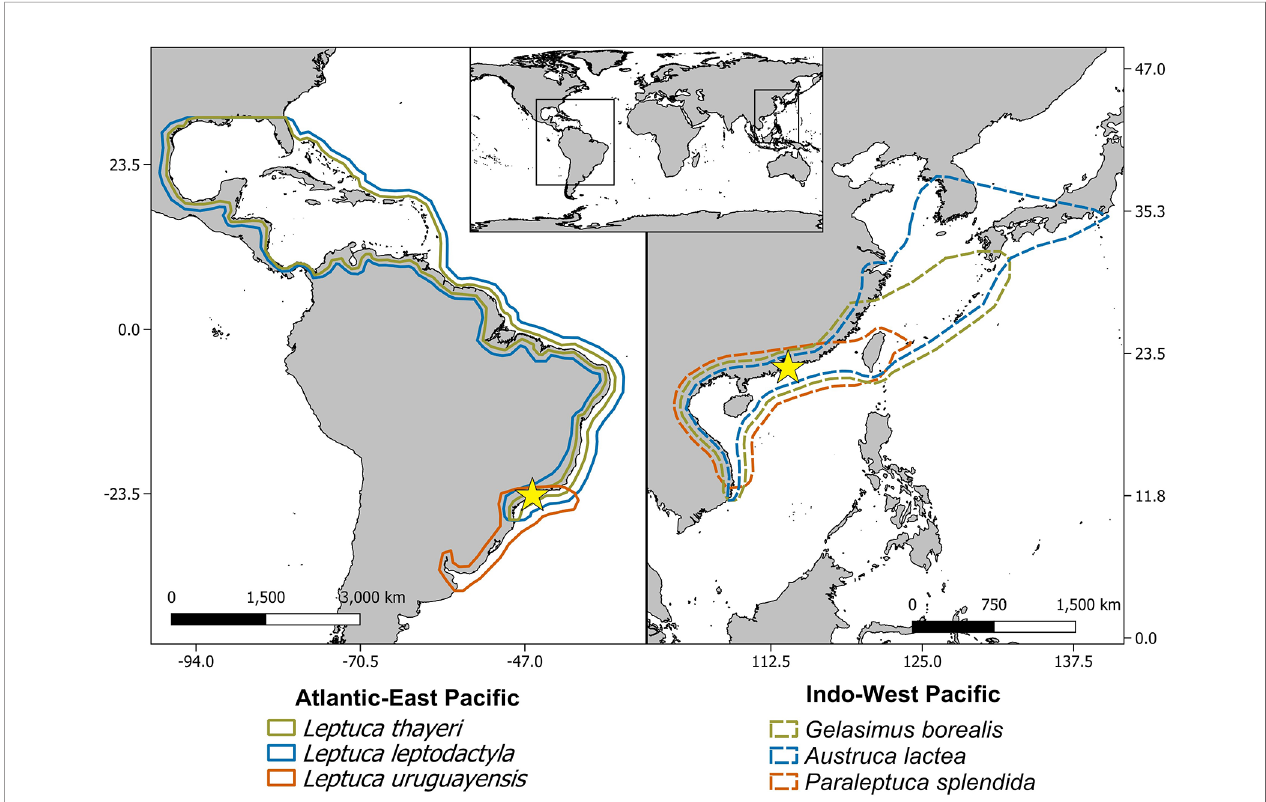
FIGURE 1 | Map showing the latitudinal range of the model species (based on Shih, 2012; Shih et al., 2012; Thurman et al., 2013; Kostina et al., 2016; Shih et al., 2016b; Yuhara et al., 2017). Yellow stars represent the sampling areas: Itaguare ́ river mouth, Bertioga, São Paulo, Brazil in the Atlantic-East Paci fi c, and Tung Chung, Hong Kong SAR, PR China in the Indo-West Paci fi